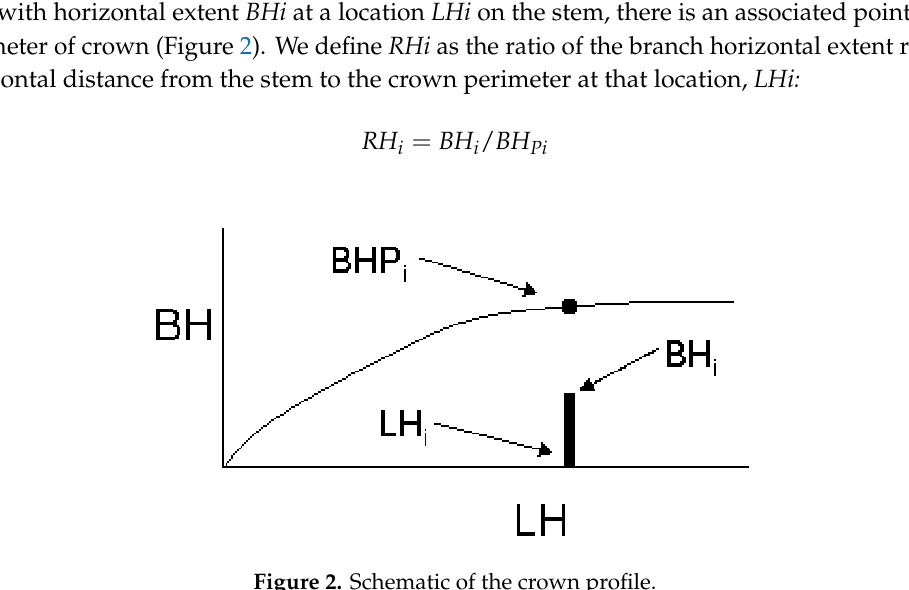
Figure 2. Schematic of the crown profile.